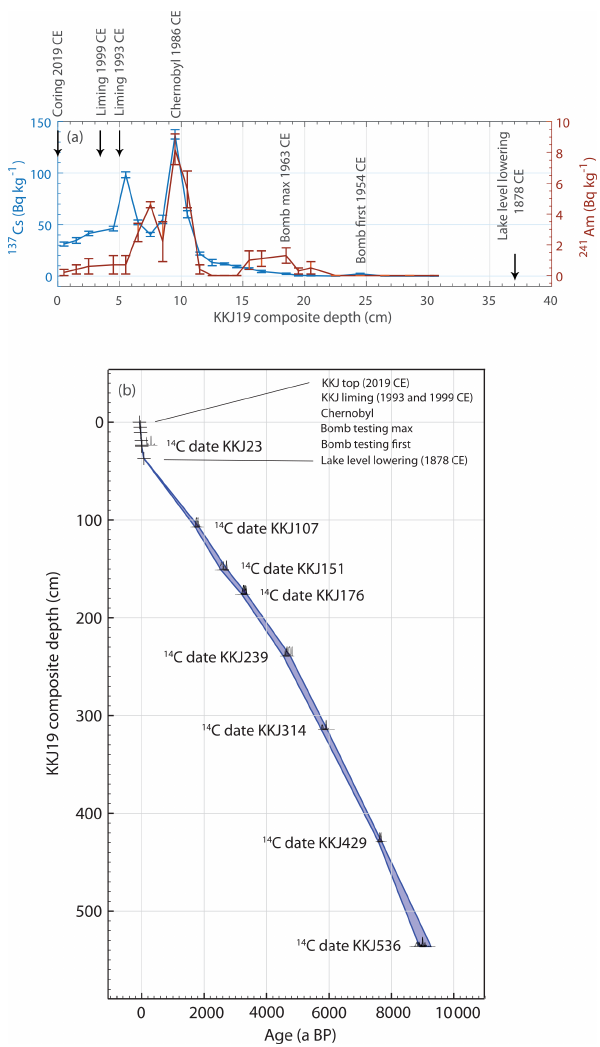
Figure 9. Age–depth model for composite sediment profile KKJ19. (a) 137 Cs and 241 Am dating of the topmost sediments and posi- tions of lithological marker layers of known age. (b) Calibrated 14 C dates from eight plant macrofossils. The age–depth model was con- structed using the OxCal software working with the IntCal20 cali- bration curve (Bronk Ramsey, 2008; Reimer et al., 2020).